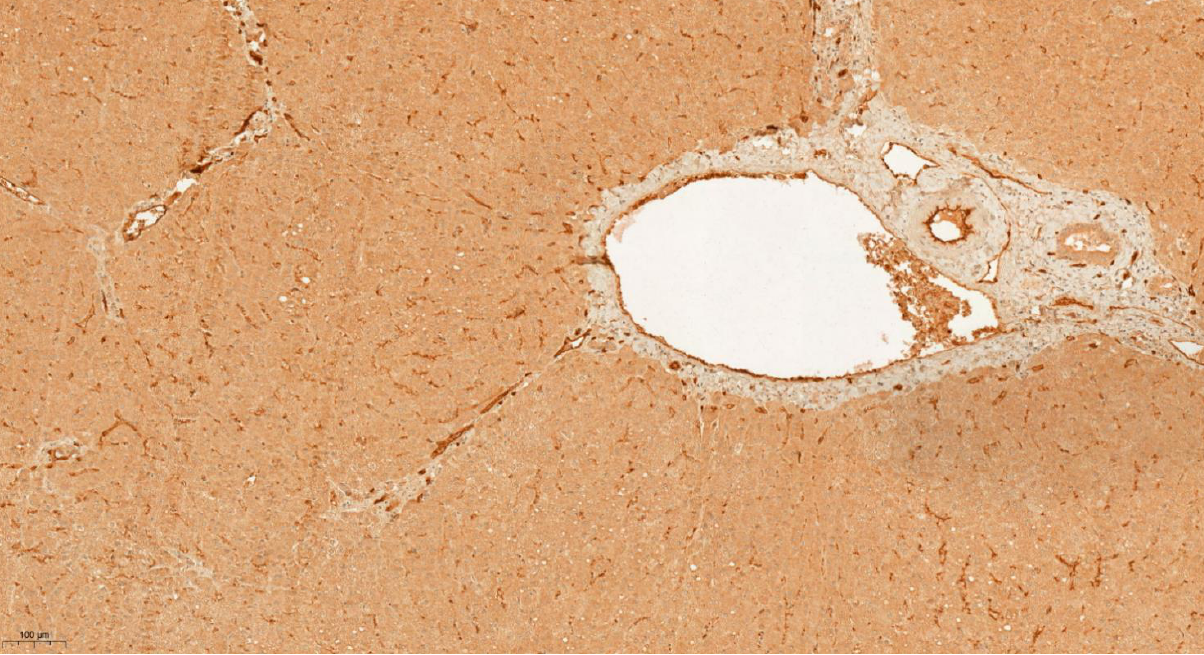
Figure 8. IHC characteristics of meprin A subunit a (MEP1A) in normal liver at low power magnification (X10). The brown chromogen indicated protein expression of MEP1A in the cytoplasm of the hepatic and stromal cells. The slide section of a normal liver contains normal appearing portal tract and hepatocytes — demonstrating mild intensity of nuclear and cytoplasmic staining for MEP1A (Allred score 1).